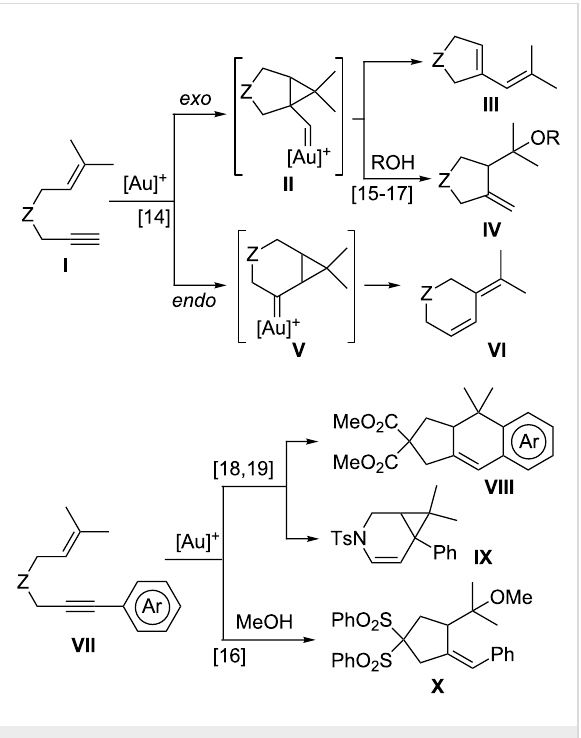
Scheme 1: Gold(I)-catalyzed reactions of 1,6-enynes.